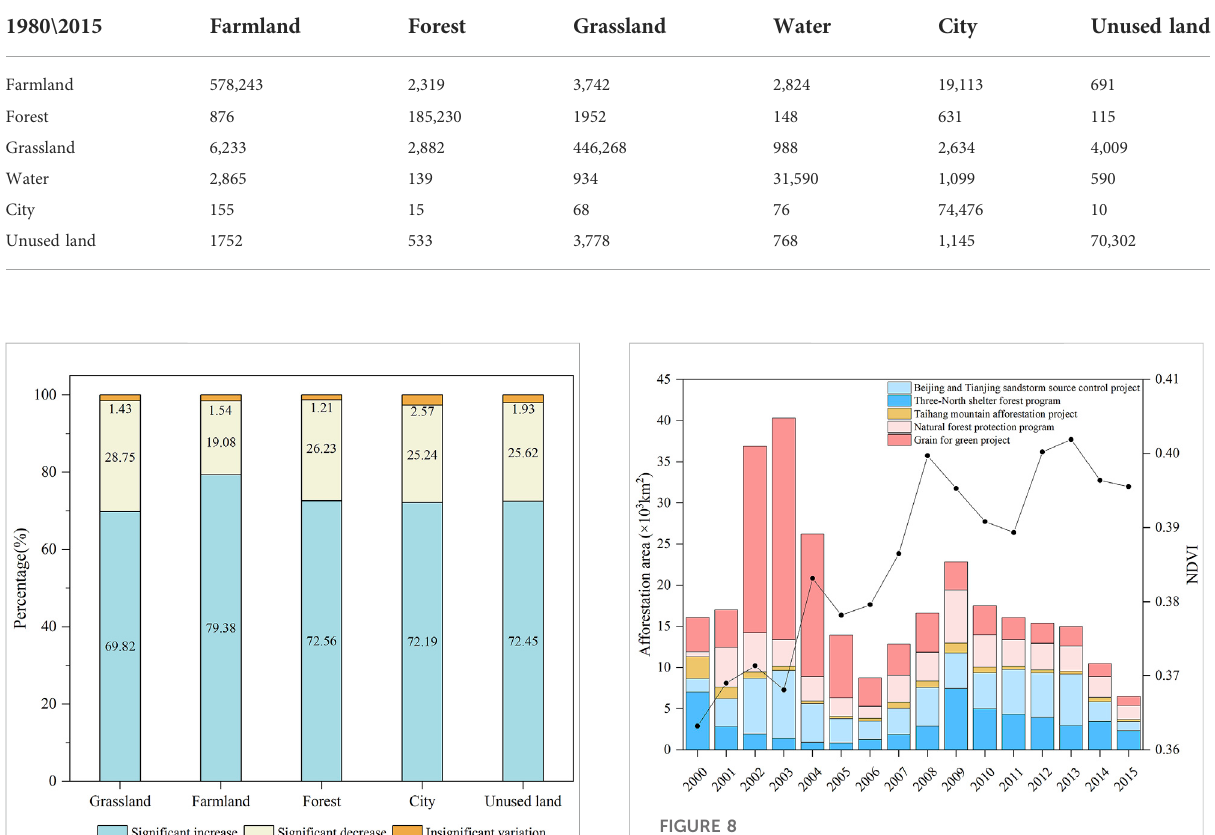
FIGURE 8 Statistical results of the NDVI and afforestation area in the YHHRB from 2000 to 2015. The bar graph represents the change in the afforestation area, and the line graph represents the NDVI